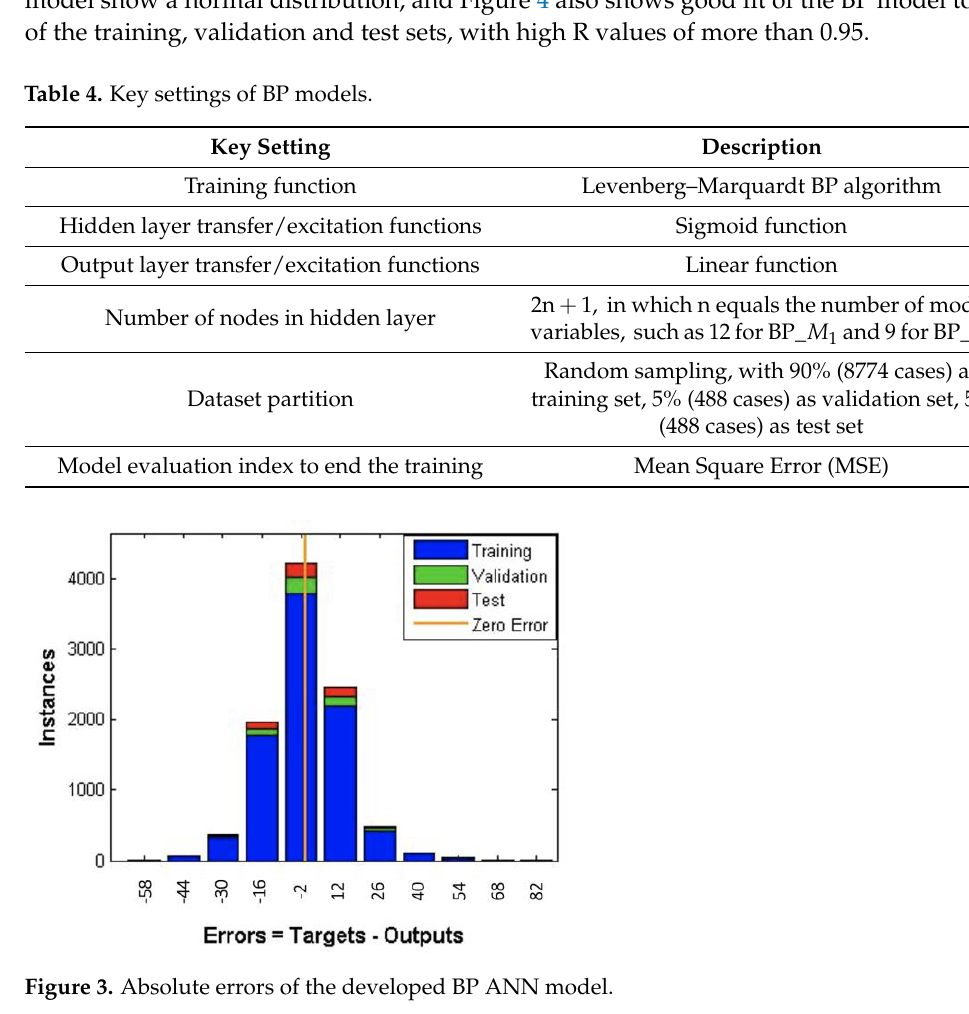
Figure 4. Fitting results of the developed BP ANN model for training, validation and test sets. Similar to the application of MVS from the perspective of forward simulation in Sec- tion 3.2, this study compares the prediction accuracies of the three models with different numbers of model input variables when they are used in actual office building cases. Table 5 provides the model errors of annual EUI prediction for the two buildings cases, and the results are analyzed based on several instances of BP modeling with the same settings,